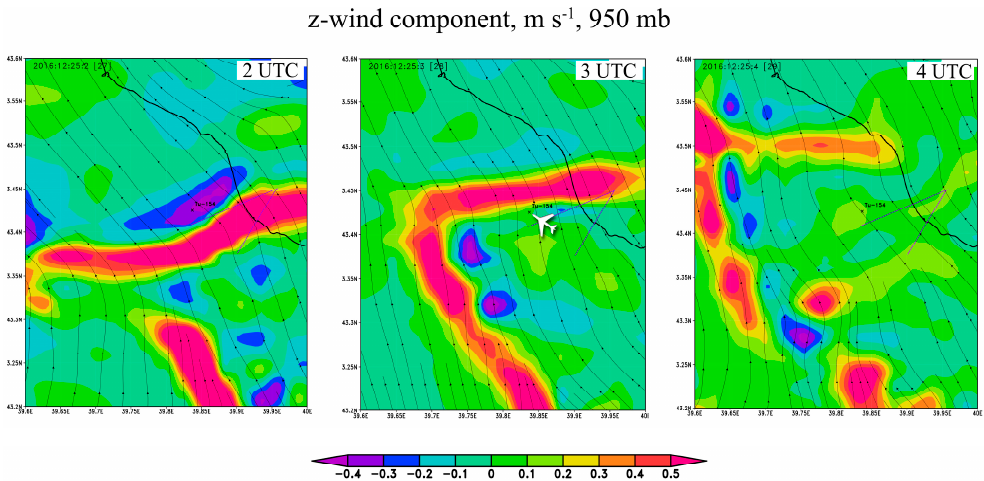
Figure 5. The Tu-154 crash site, Russia, 2016. The z-wind speed 1 h before the crash (2 UTC); at the moment of the crash (3 UTC); 1 h after the crash (4 UTC). Two glissades are specified by blue lines. Additionally, the horizontal ( u, v ) wind streamlines are